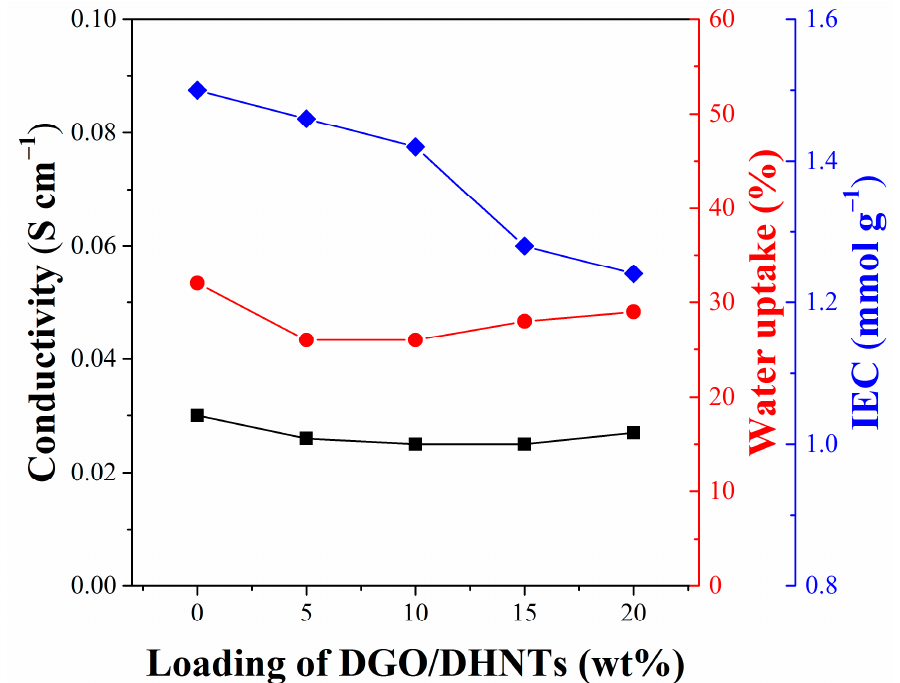
Figure 2. Proton conductivity, water uptake, and IEC of SPEEK/DGO/DHNTs composite mem- branes.